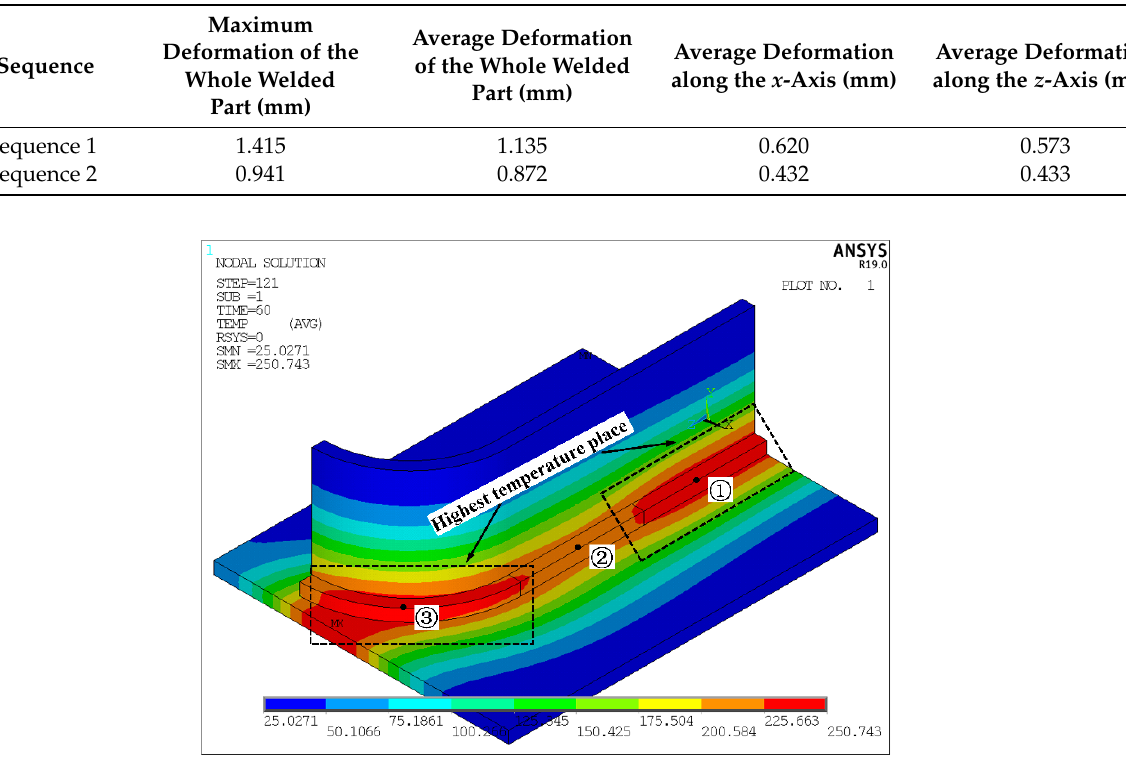
Table 2. Deformation comparison of the arc welded part.